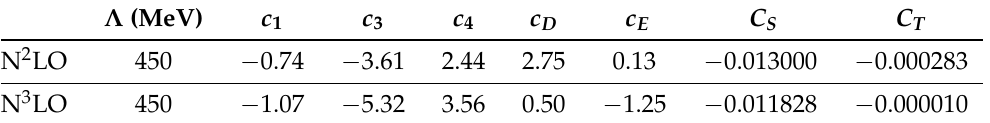
Table 1. Values of the LECs c 1,3,4 , c D , c E , C S , and C T at N 2 LO and N 3 LO. The momentum-space cutoff − 1 , while c Λ is equal to 450 MeV. The LECs c D and c E are dimensionless. 1,3,4 are given in units of GeV